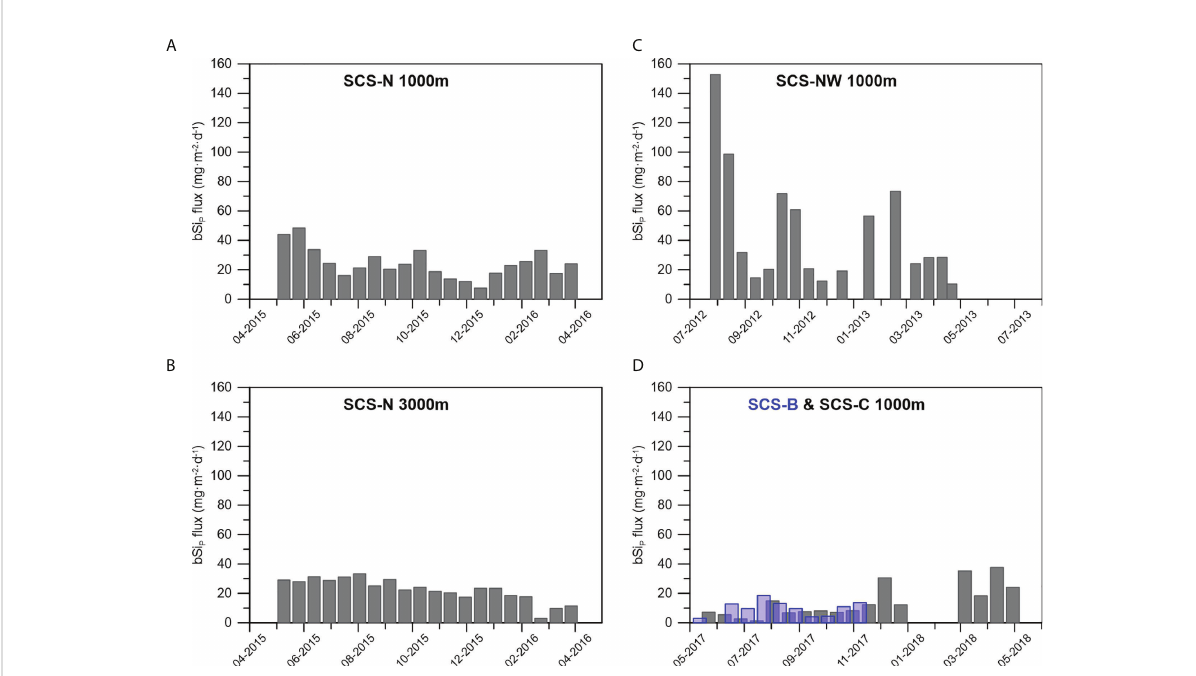
FIGURE 4 The bSi P fl ux at different stations at 1000m of station SCS-N (A) , 3000 m of station SCS-N (B) ,1000m of station SCS-NW (C) and 1000 m of station B & C with the blueish bars representing the data of SCS-B (D) .